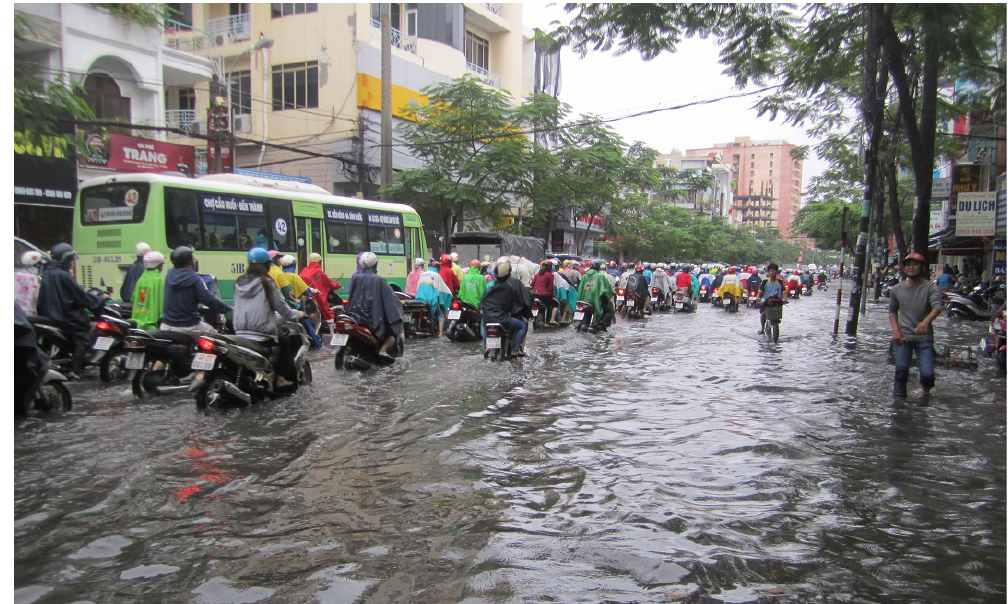
Figure 10. Flooding and water nuisance in HCMC. City residents tried to drive through floodwater. This photograph was taken by Mrs. Ngo Yen Nhi, at 117 Dinh Bo Linh street, Ward 26, Binh Thanh District, at 8:42 a.m. 7 November